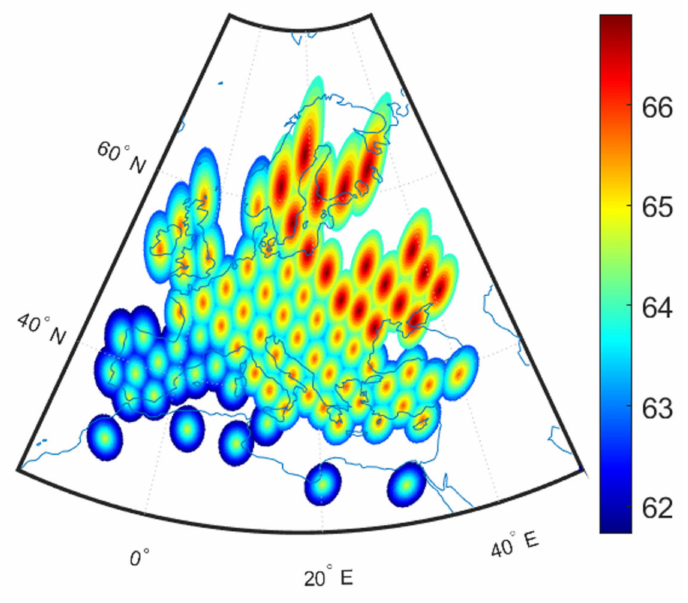
Figure 16. EIRP (dBW) map over service area using irregular coverage for 4 regions. Based on this coverage, Table 2 presents the standard deviation and variance resulting when the antenna axis A 0 orientation is set to spots 41 (the best) and to spot 7. Note that the minimum values are obtained for the spot b =